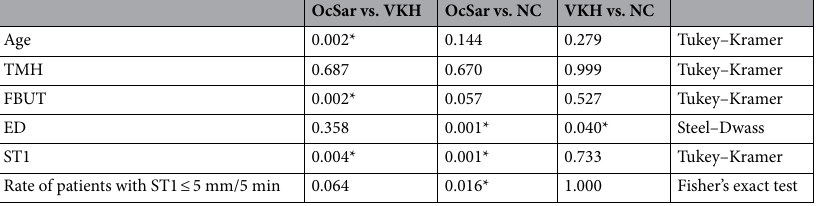
Table 2. Statistical comparison of the demographic data between the OcSar group, VKH group, and NC group. OcSar ocular sarcoidosis, VKH Vogt-Koyanagi-Harada disease, NC normal control, TMH tear meniscus height, FBUT fluorescein breakup time, ED keratoconjunctival epithelial damage, ST1 Schirmer 1 test. *Statistically significant difference.